Question: Looking at the figure, what chart type is it?
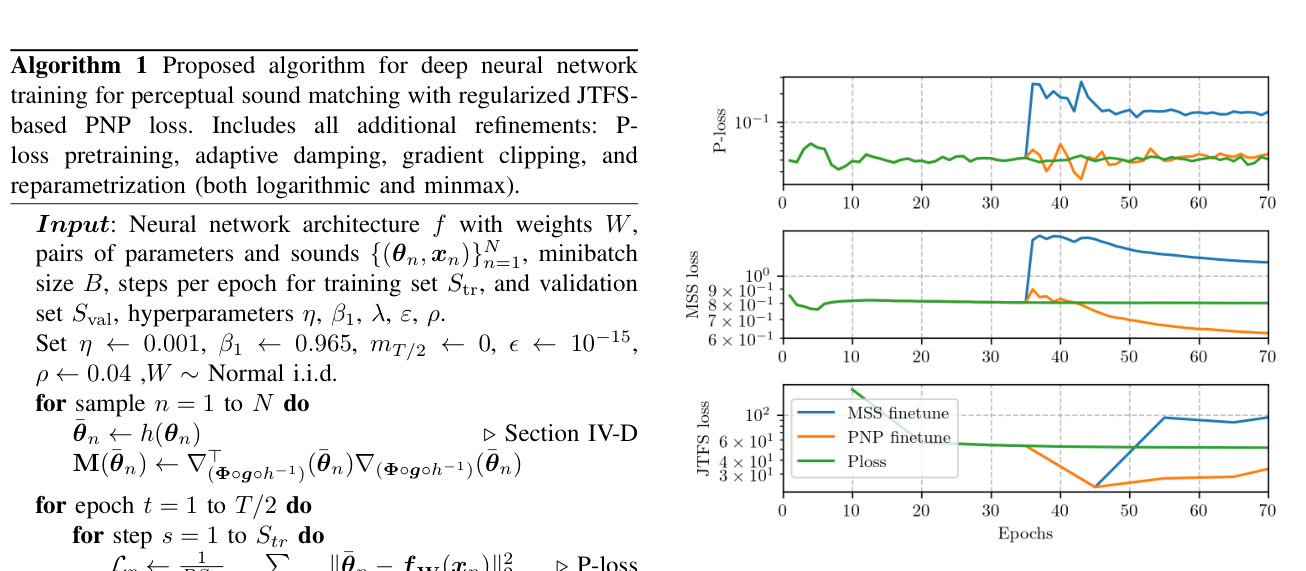
Answer: line